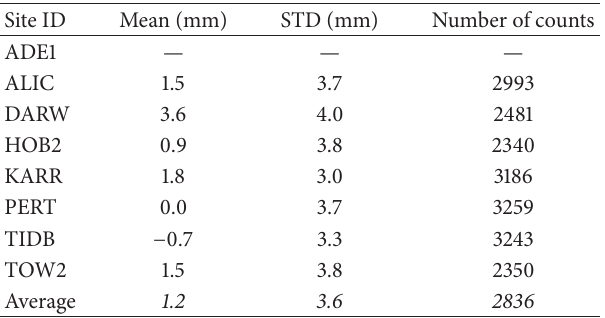
Table 2: Average differences (mm) between the computed ZPD estimates from GA and USNO for 2011. Note that no GPS data were recorded at ADE1 in 2011.